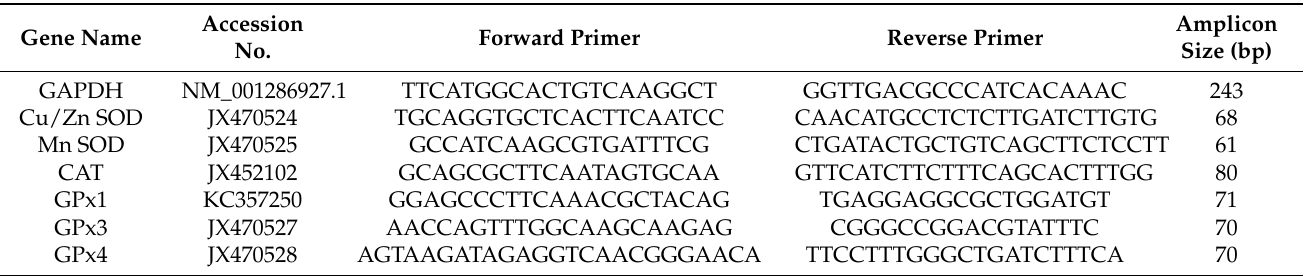
Table 1. Gene name, GeneBank accession number, forward and reverse primer sequences and primer amplicon size for target genes